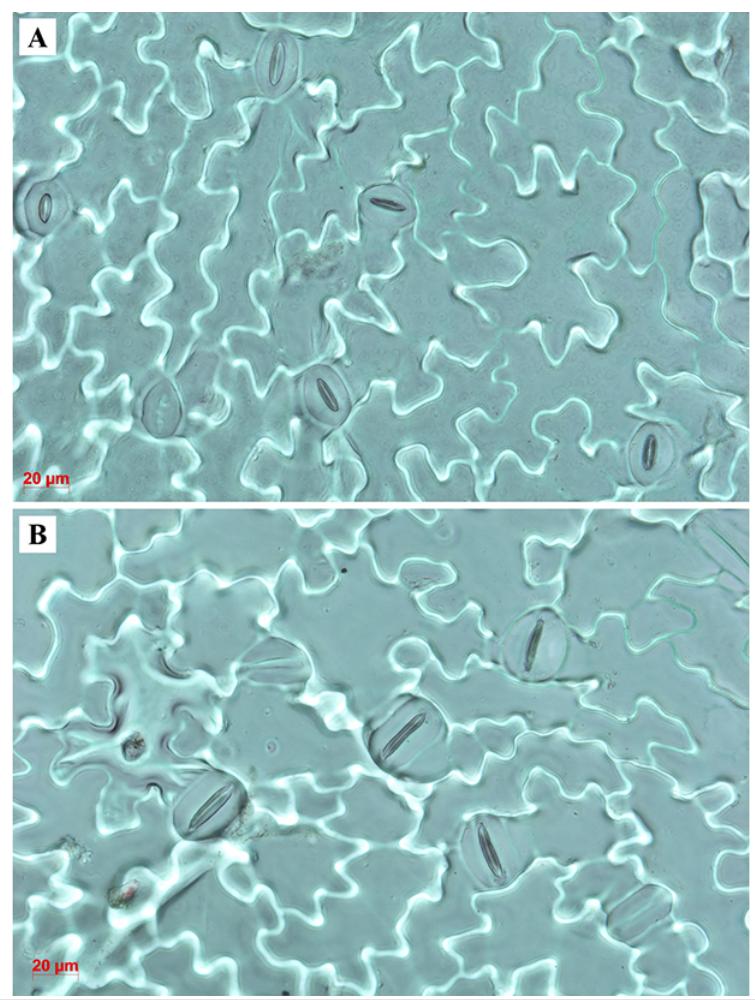
Fig. 4 The morphology of stomata, their size and density in H. lupulus (Clone 72, Sample 25). ( A ) Diploid control plant (length 27.7 ±2.16 µm, width 17.61 ±1.85 µm). ( B ) Tetraploid plant (length 37.87 ±3.82 µm, width 23.18 ±2.55 µm). Scale bar is 20